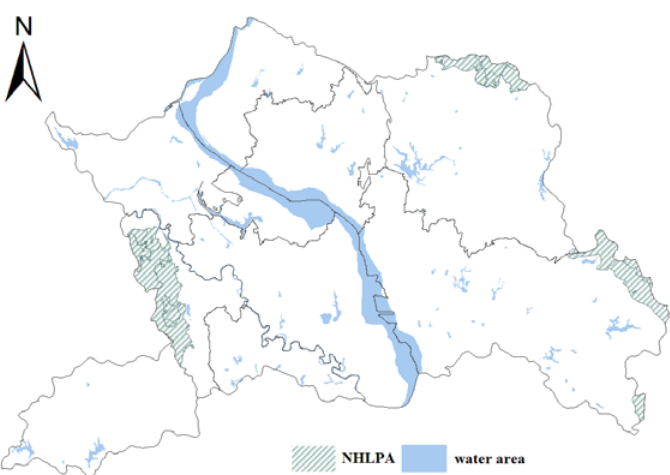
Figure 4. Water and nature reserve areas in